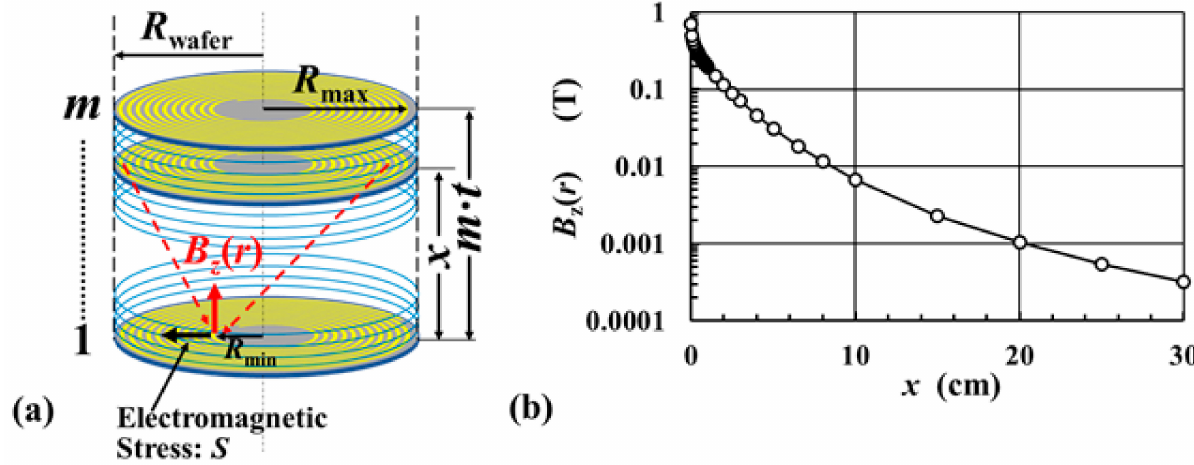
Figure 8. ( a ) Schematic illustration of the magnetic flux density in the innermost trench of a wafer coil indicated with a red arrow caused by a different wafer coil stacked above at x . Alongside, the generated electromagnetic hoop stress is also indicated by a radial outward-directed black arrow. ( b ) Dependence of the magnetic flux density B z (r) on x .